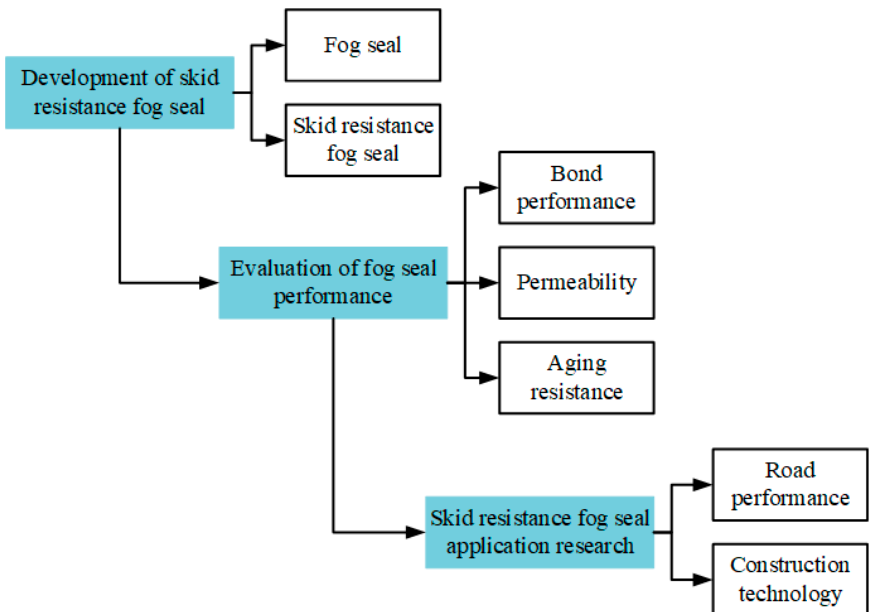
Figure 11. Skid resistance fog seal development and performance verification process.